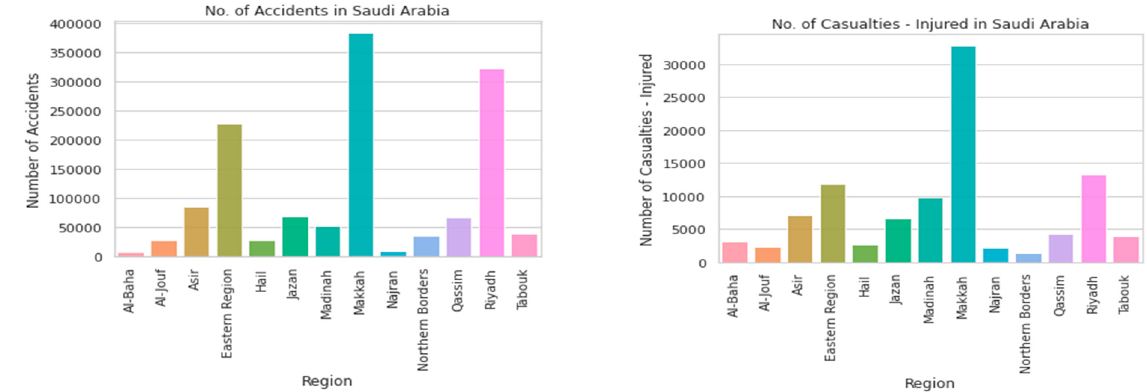
Figure 7. Number of accident and injuries in Saudi Arabia.